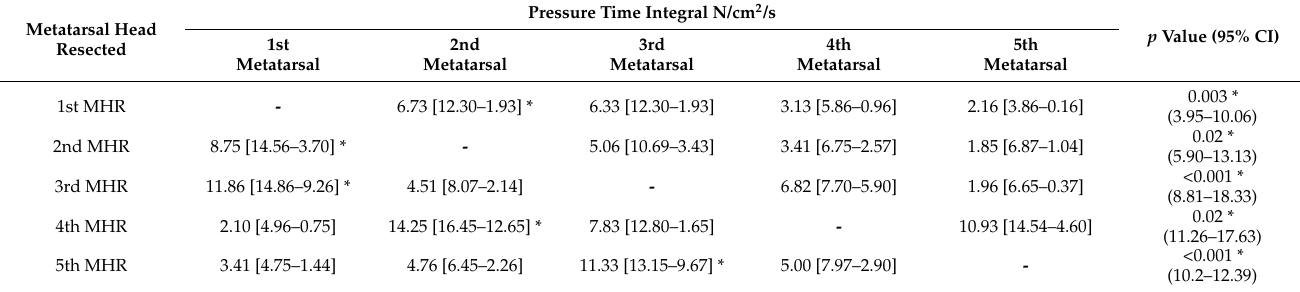
Table 3. Pressure time integral in the adjacent metatarsal heads after the first metatarsal head resection procedure. Metatarsal Head